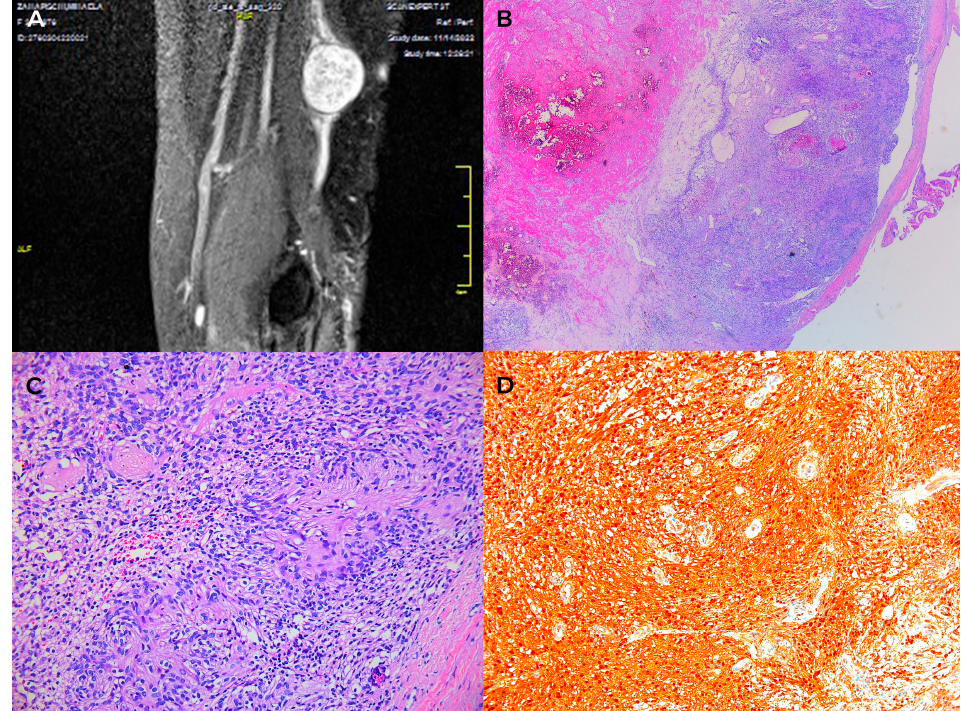
Figure 7. Schwanoma. ( A ) MRI aspect. ( B , C ) Encapsulated well-circumscribed lesion beneath the uninterrupted epidermis. The tumor is composed of different areas composed of different cellular densities. More cellular areas (Antoni A) are composed of a haphazard arrangement of bland cells with spindled and oval nuclei. Loose, less cellular areas (Antoni B) are composed of a loose oedematous and mucinous stroma with fibrillar collagen. The vessels are prominent and often surrounded by dense sclerosis. ( B ) HE × 10; ( C ) HE × 20; ( D ) Diffuse positive immunoreactivity for